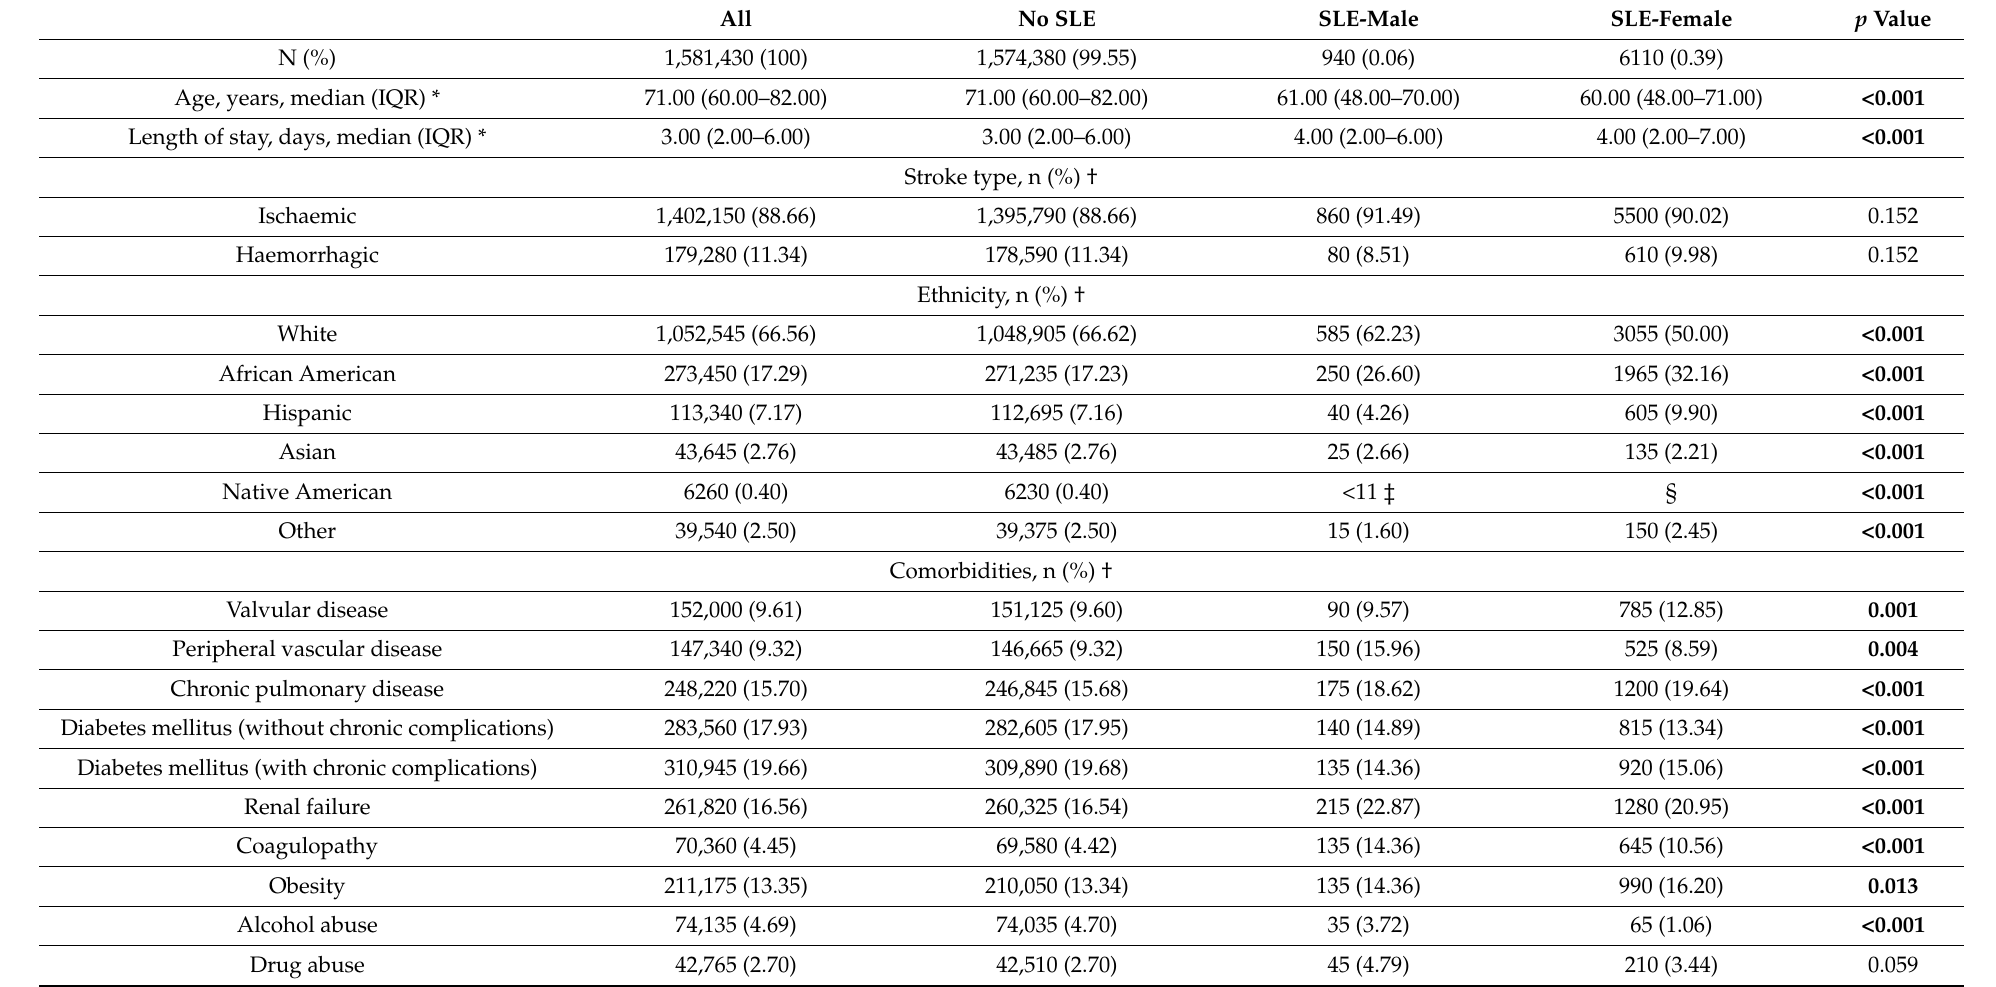
Table 1. Baseline characteristics on admission of male and female stroke patients with and without comorbid SLE. Further descriptive statistics are detailed in Supplementary Table